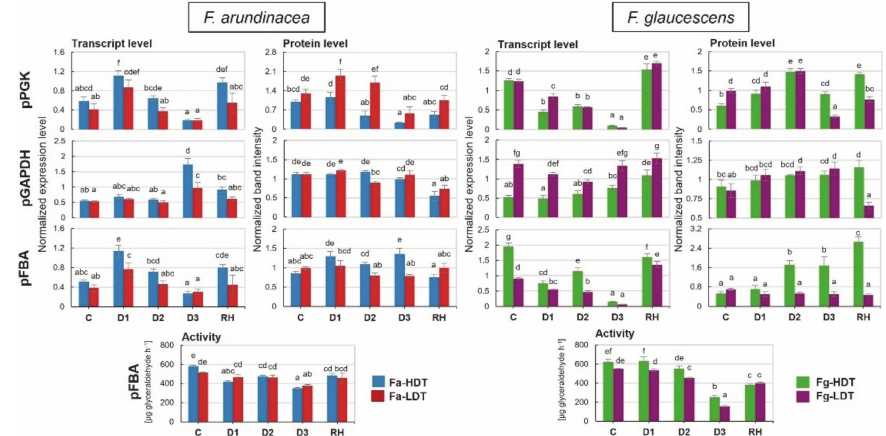
Figure 2. Transcript and protein accumulation level of plastid phosphoglycerate kinase ( pPGK ), plastid glyceraldehyde-3-phosphate dehydrogenase ( pGAPDH ), plastid fructose-1,6-bisphosphate aldolase ( pFBA ), and the activity of pFBA in two genotypes of F. arundinacea (Fa-HDT, Fa-LDT) and F. glaucescens (Fg-HDT, Fg-LDT) before stress treatment (C), on the 3rd (D1), 6th (D2), and 11th (D3) day of water deficit and 10 days after re-hydration initiation (RH). The transcript accumulation levels of actin and ubiquitin were used as references. Error bars represent the standard errors (SE) of three biological and two technical (transcript level and activity) or three biological (protein level) replicates. Homogeneity groups are denoted by the same letters, according to Fischer LSD test ( p =